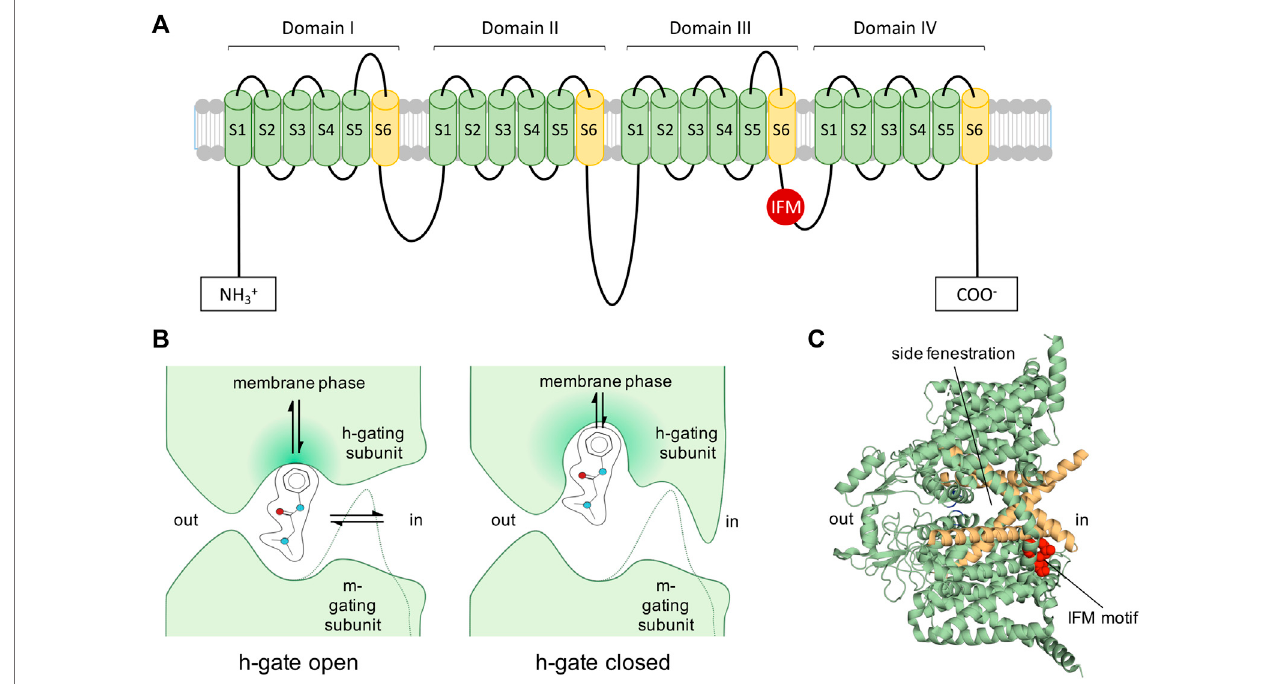
FIGURE 2 | Voltage-gated Navs as targets of LAs. (A) : 2D representation of Nav. Inactivation motif is indicated by red circle labelled with IFM (isoleucine, phenylalanine, methionine). (B) : View of 1977: Diagram of a LA molecule binding into the pore of a Nav indicating the activation gate (m-gate) and inactivation gate (h-gate) according to an early view and description of Nav modi fi cation (Hille, 1977). LAs were assumed to enter via the membrane phase or passing the m- and h-gate from the intracellular side. Many assumptions proved to be correct, such as the possibility for LAs to enter into the channel ’ s pore from the membrane phase. The fi gurewaspartiallyreadaptedfrom(Hille,1977). (C) :Cryo-EMstructureofhNav1.7(Shenetal.,2019)(PDBID:6J8G)depictingthesidefenestrations,whichallowLAsto enter the channel from the lipid phase and the inactivation motif (IFM-motif, shown in red), which was previously described as